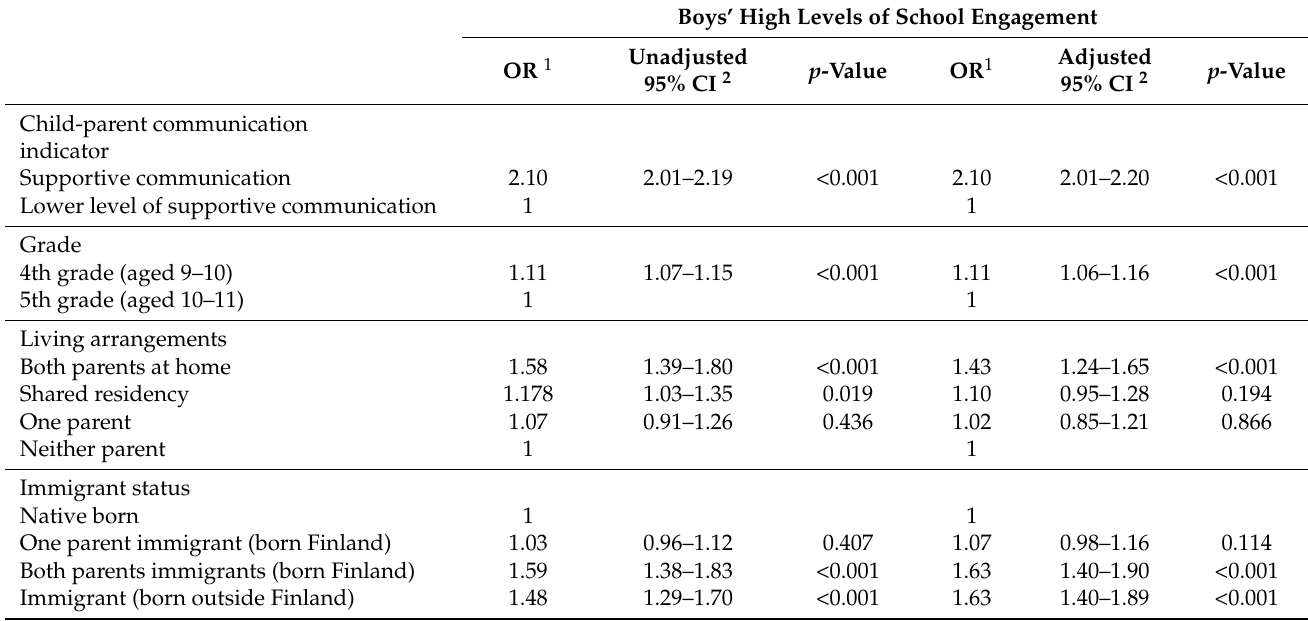
Table 7. ORs and 95% CIs for background factors and child-parent relationships of girls aged 9–11 years in relation to high level of school engagement